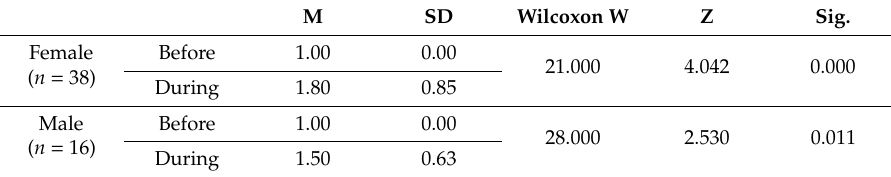
Table 7. Quantity of PA, individuals who did not practice PA before the